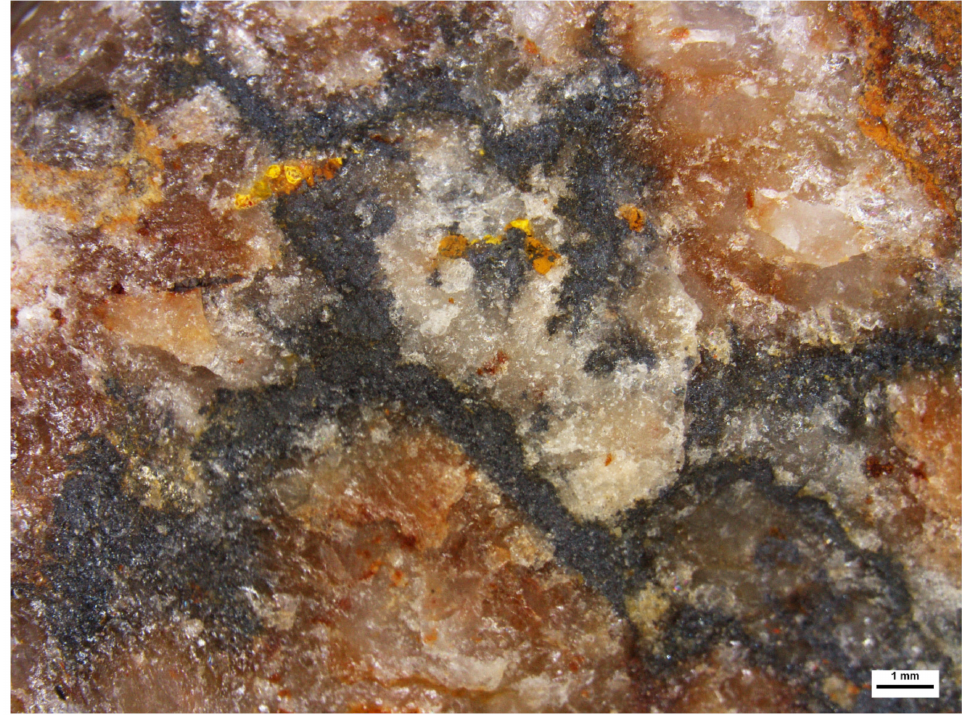
Figure 2. Irregular veinlets of U-Mo mineralization in limonitized quartz. The small cavities in the quartz are filled with a yellow uranyl molybdate—iriginite. Photo: Š.